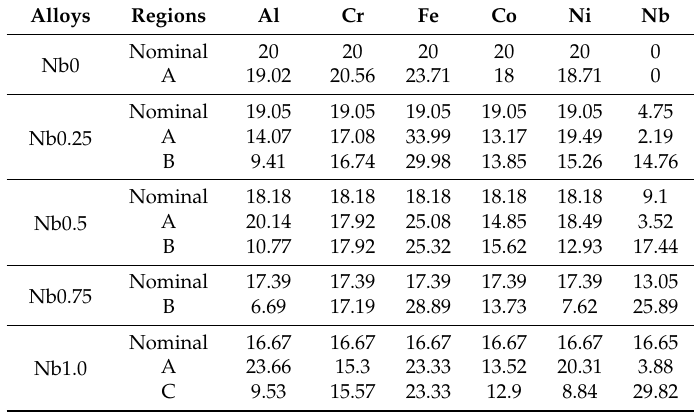
Figure 3. Scanning electron microscopy (SEM) images of high entropy alloy (HEA) coatings: ( a ) Nb0, ( b ) Nb0.25, ( c ) Nb0.5, ( e ) Nb0.75, ( f ) Nb1.0; ( d ) magnification of the Nb0.5 alloy coating. The image inserted in (b) was the high magnification of the B region in Nb0.25 alloy coating. A = primary phase; B = eutectic region; C = another primary phase. Table 3. EDS results of the coating zone (CZ) for AlCoCrFeNiNb x (x = 0, 0.25, 0.5, 0.75, and 1.0) alloy coatings (at. %).